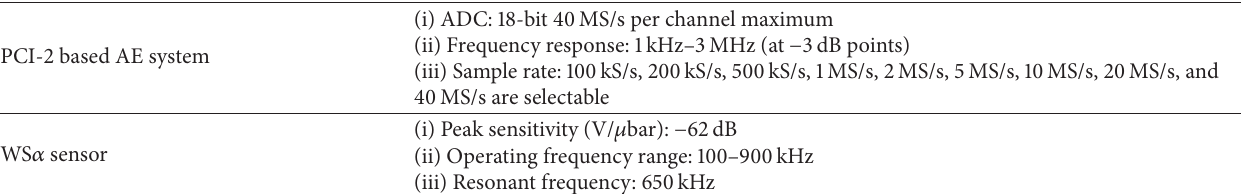
Table 4: Specifications of the data acquisition system.